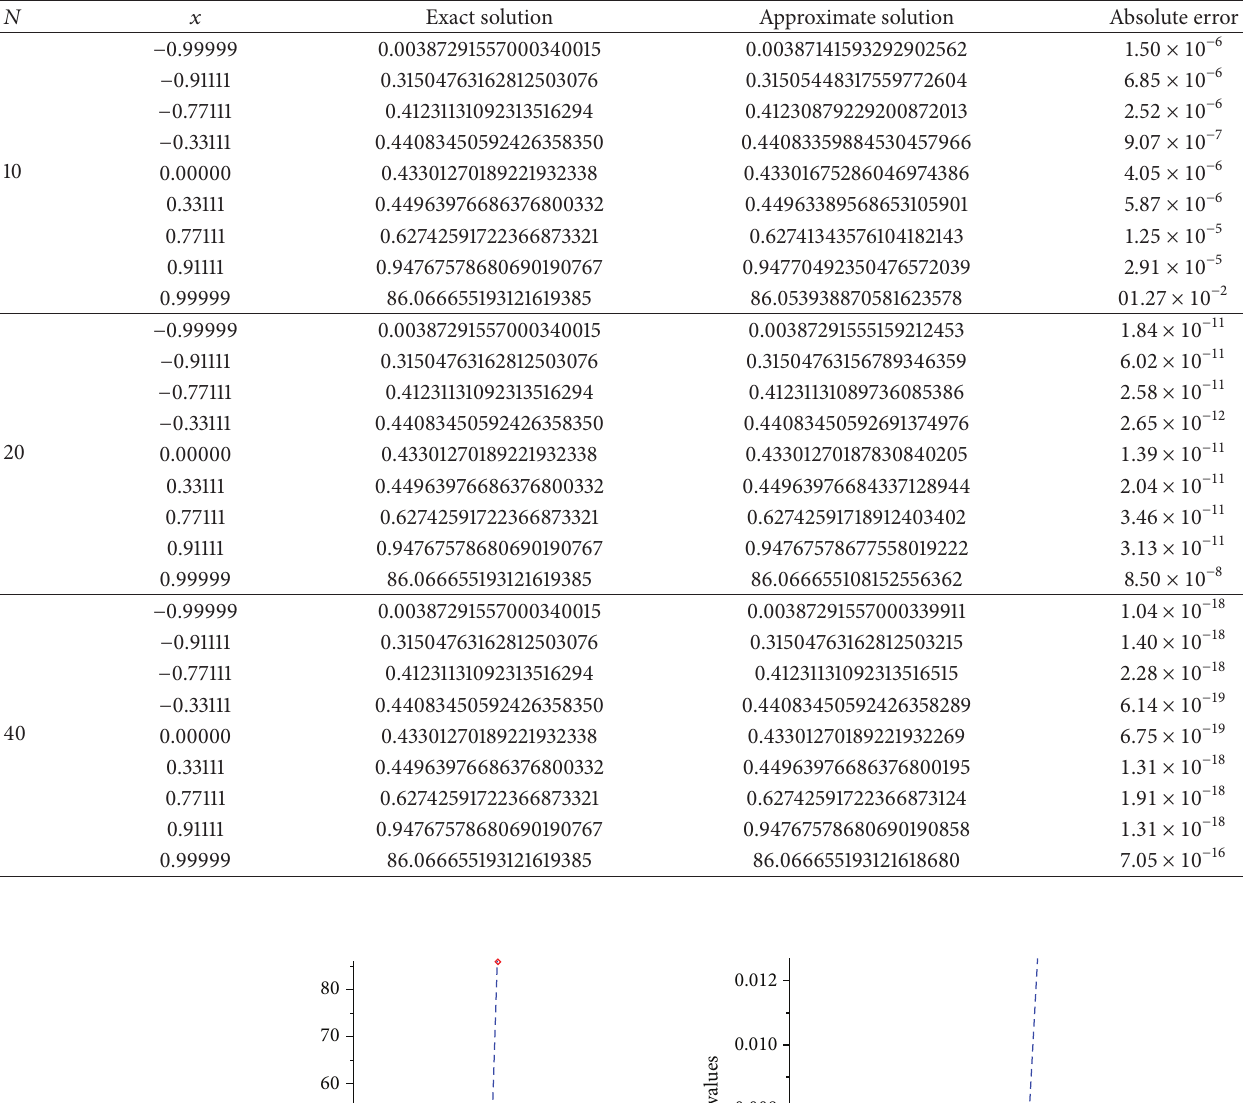
Table 4: Results of HSIs for 𝑤 2 (𝑡) .